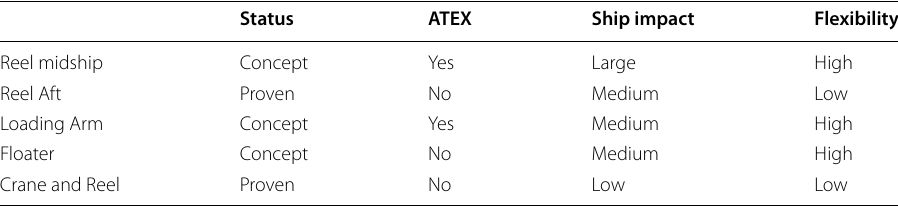
Table 1 Overview of cable management systems and qualities. Source : Authors